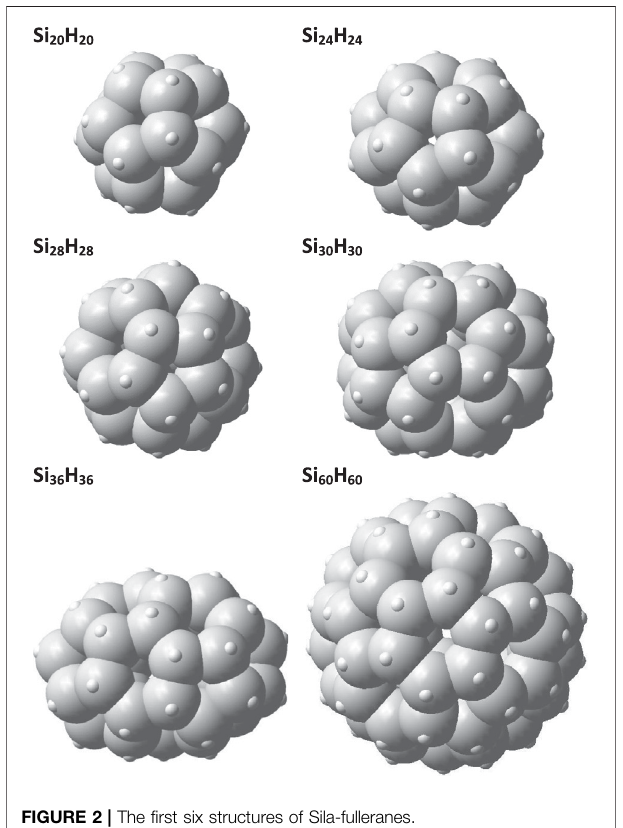
FIGURE 2 | The fi rst six structures of Sila-fulleranes.